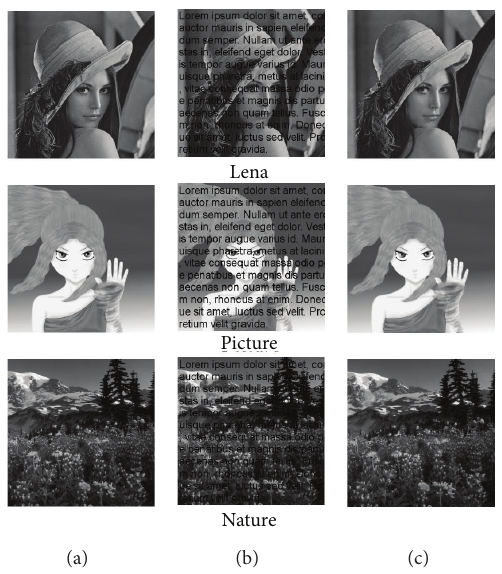
Figure 2: (a) Original image; (b) damaged image; (c) reconstructed